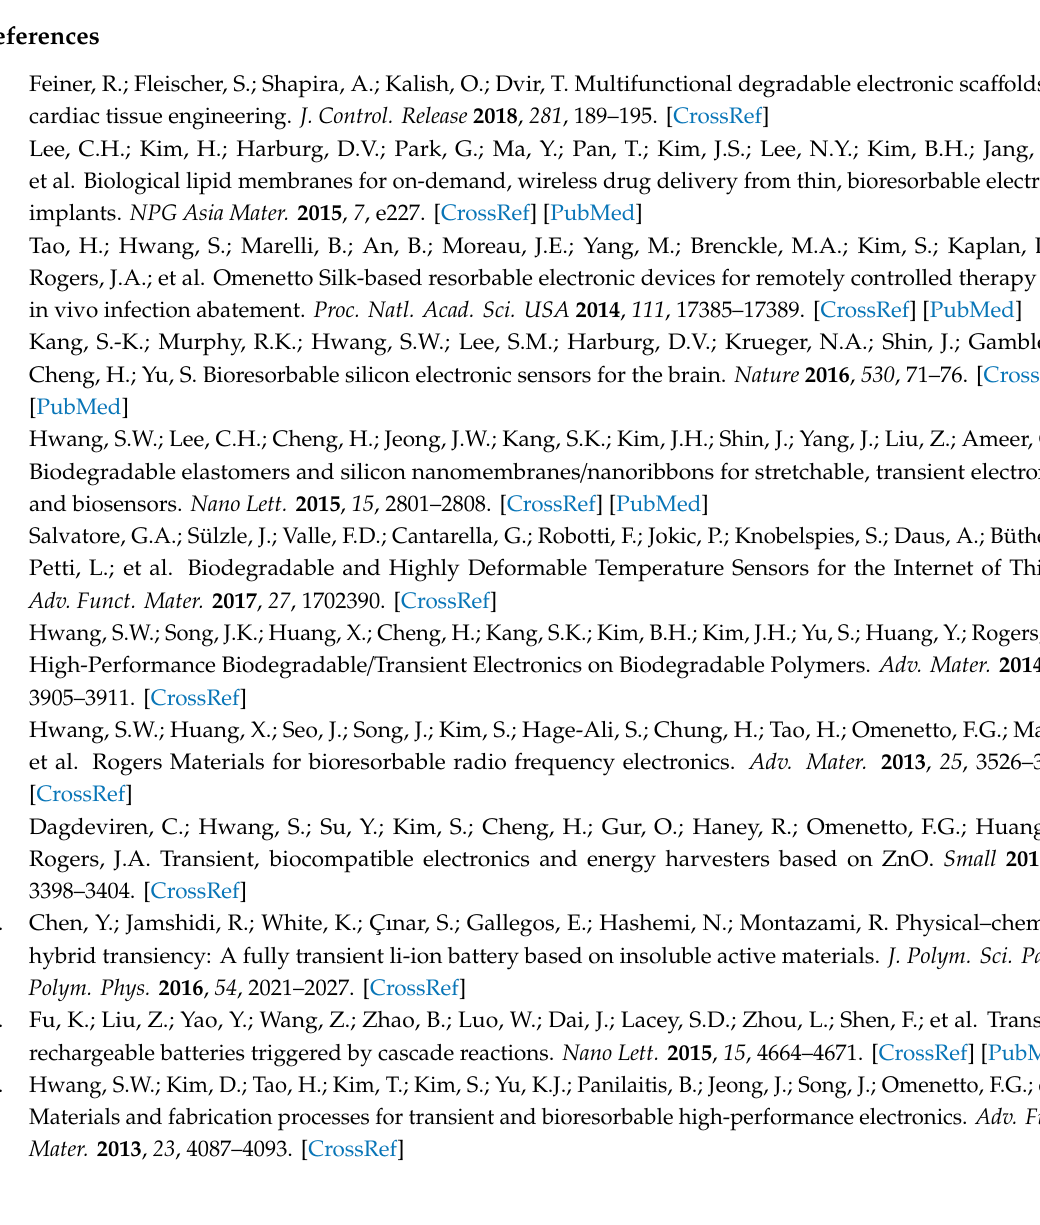
Figure S1: Contact angle between PEODOT:PSS solution droplet on PEO